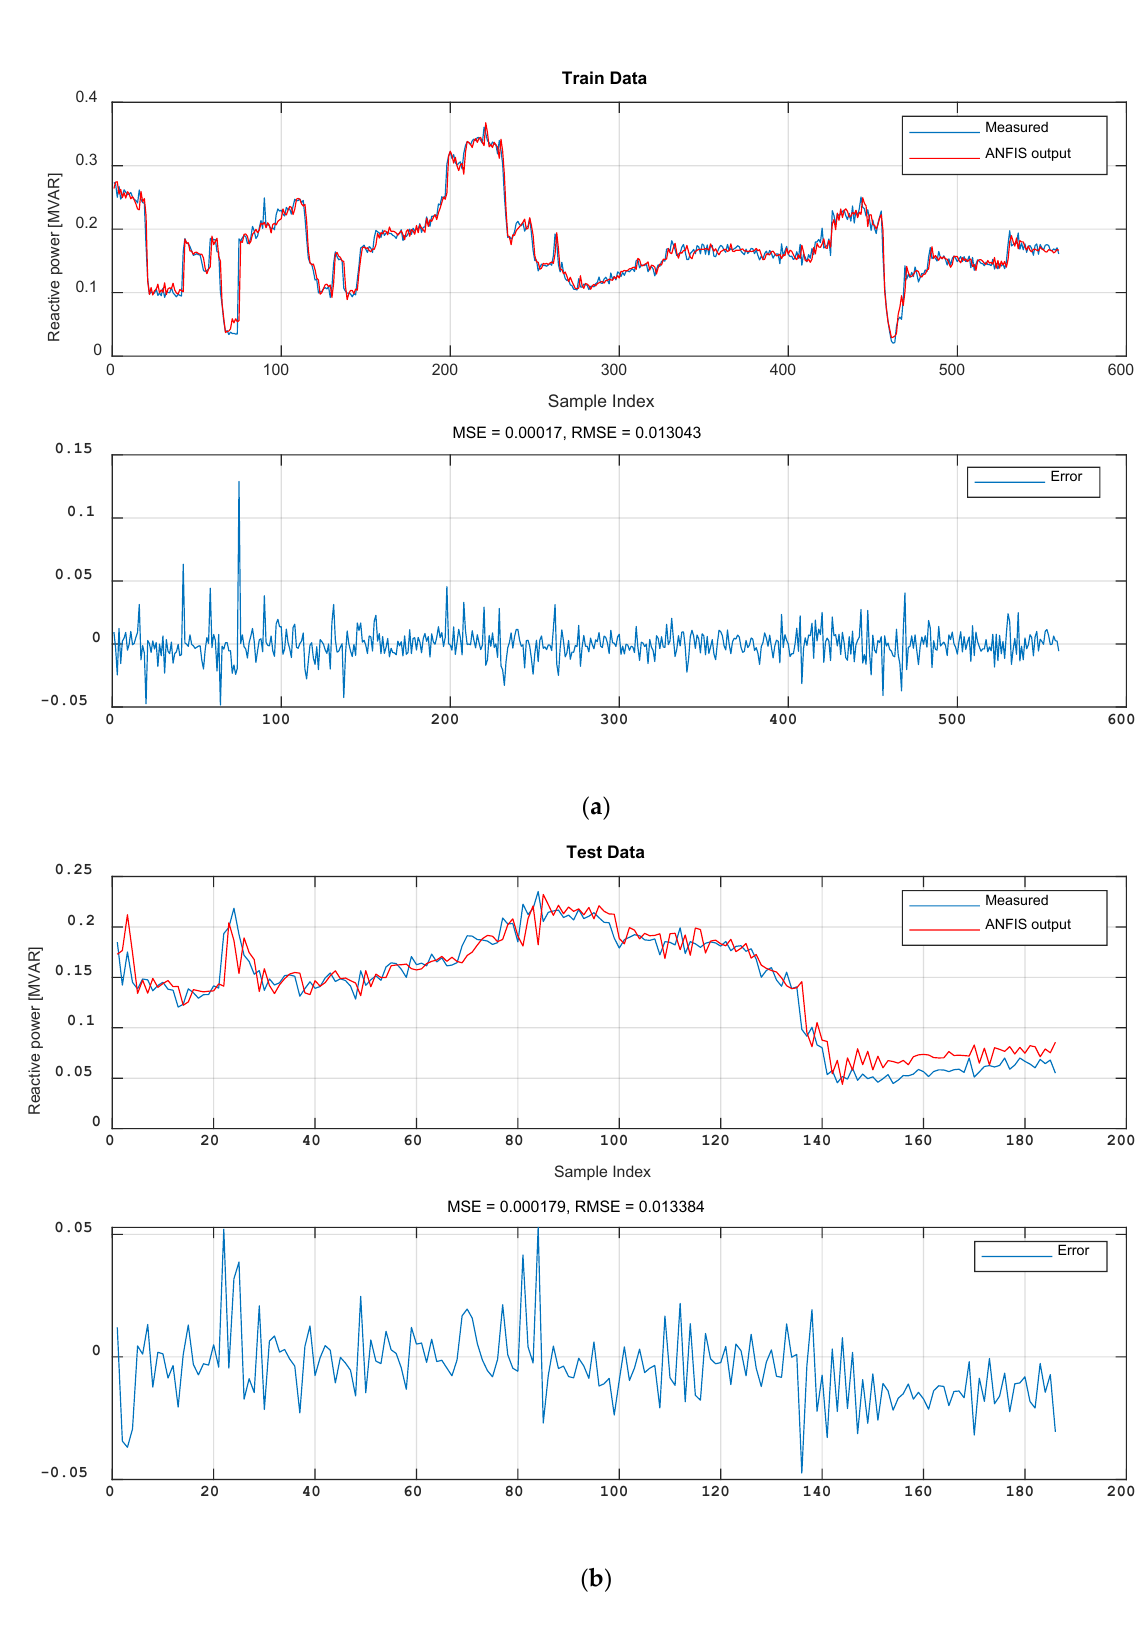
Figure 15. The variation in the measured and predicted reactive power, and also of the error for ANFIS FCM model; ( a ) for training stage; ( b ) for testing stage.